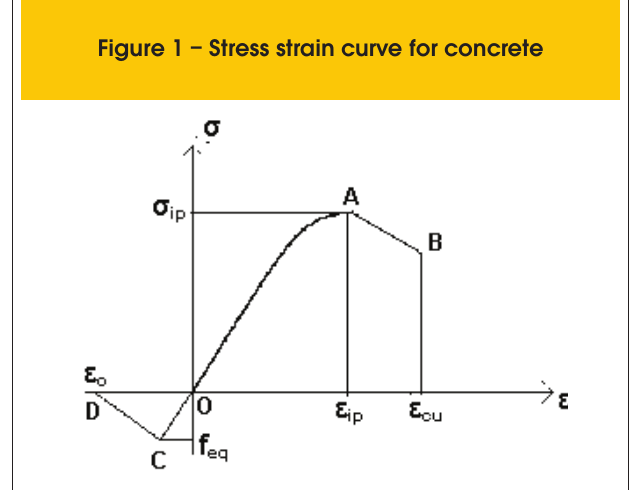
Figure 1 – Stress strain curve for